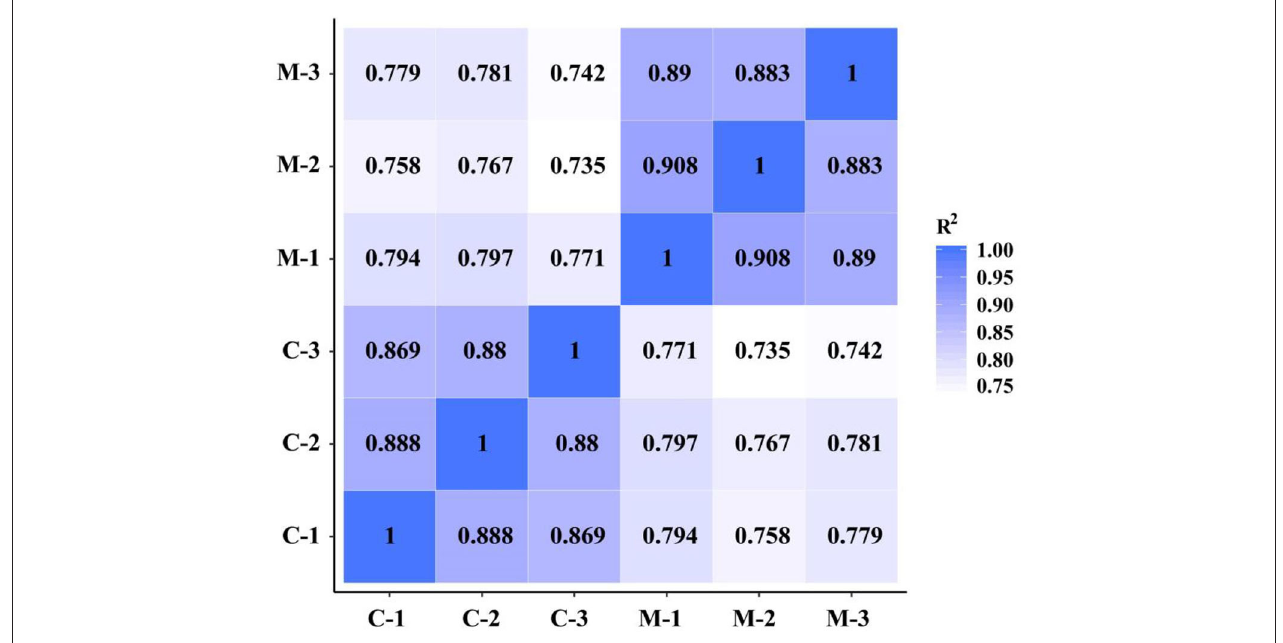
FIGURE 4 | Pearson correlation between samples of the M. microcarpa transcriptome. The number in the color block represents the value of correlation coefficient. C, samples treated at 25 ◦ C; M, samples treated at − 2.8 ◦